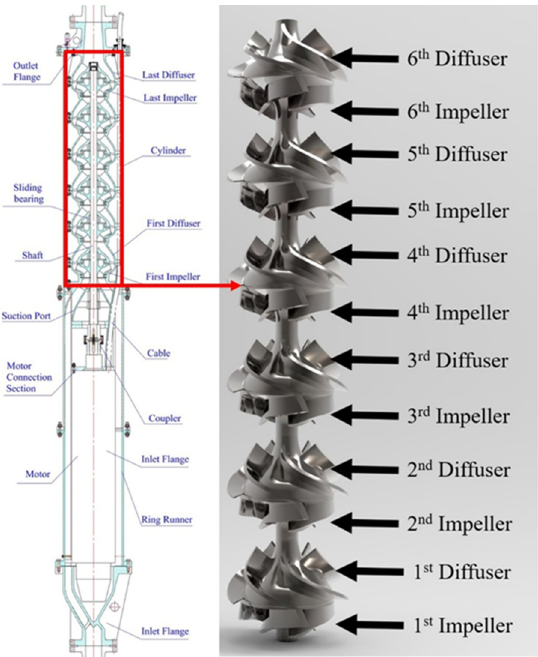
Figure 5. Design schematic of China’ s “13th Five-Year“ six-stage lifting